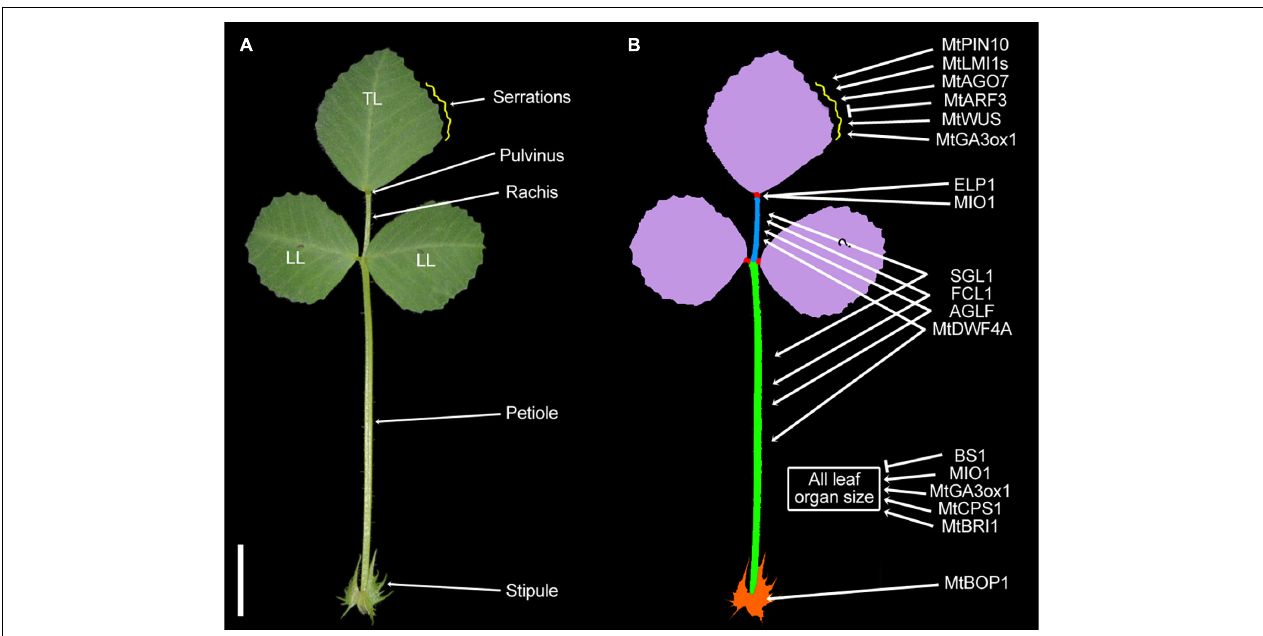
FIGURE 1 | Genes associated with the morphology of the Medicago truncatula trifoliate leaf. (A) The typical trifoliate leaf of M. truncatula consists of a terminal leaflet (TL), a pair of lateral leaflets (LL), a central rachis, and a petiole subtended by a pair of stipules (St). Each leaflet has a pulvinus at the base of the blade, functioning as the motor organ for leaf movement. The distal part of the blade ( ∼ 3/4 midvein) forms serrations (yellow curve) along the edges. (Bar, 2 cm.) (B) The diagram of the trifoliate leaf and some of the functionally characterized genes involved in regulating the morphology of serrations, pulvinus, rachis, petiole, and rachis of the trifoliate